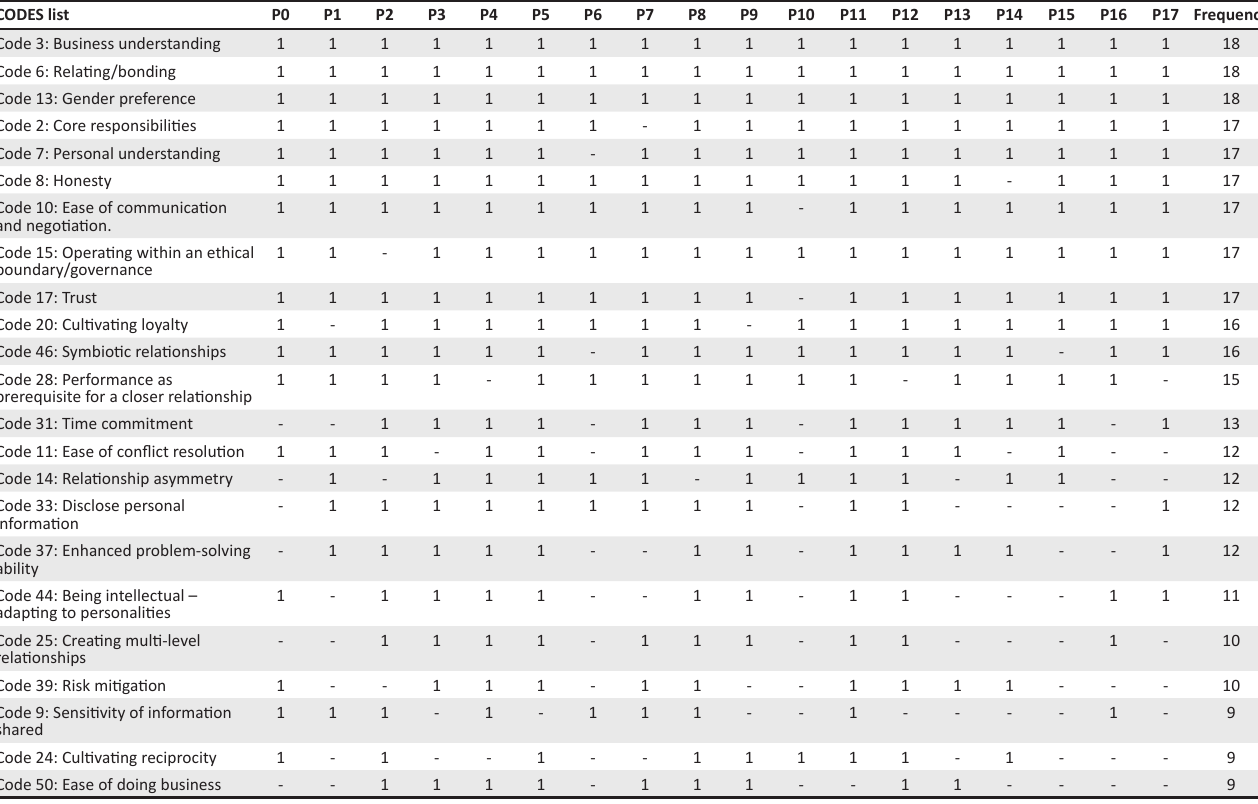
TABLE 2: Data frequency table. CODES